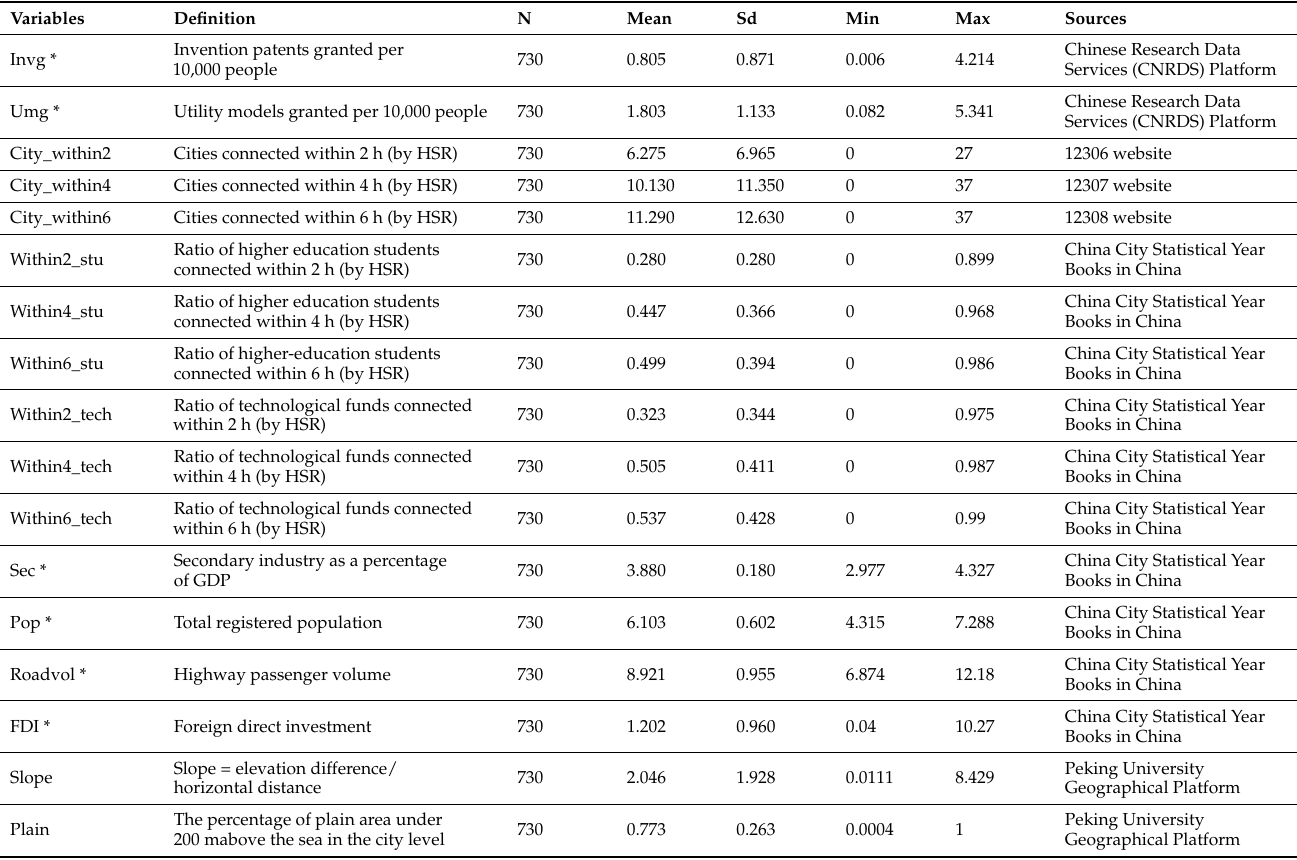
Table 1. Descriptive statistics of the model